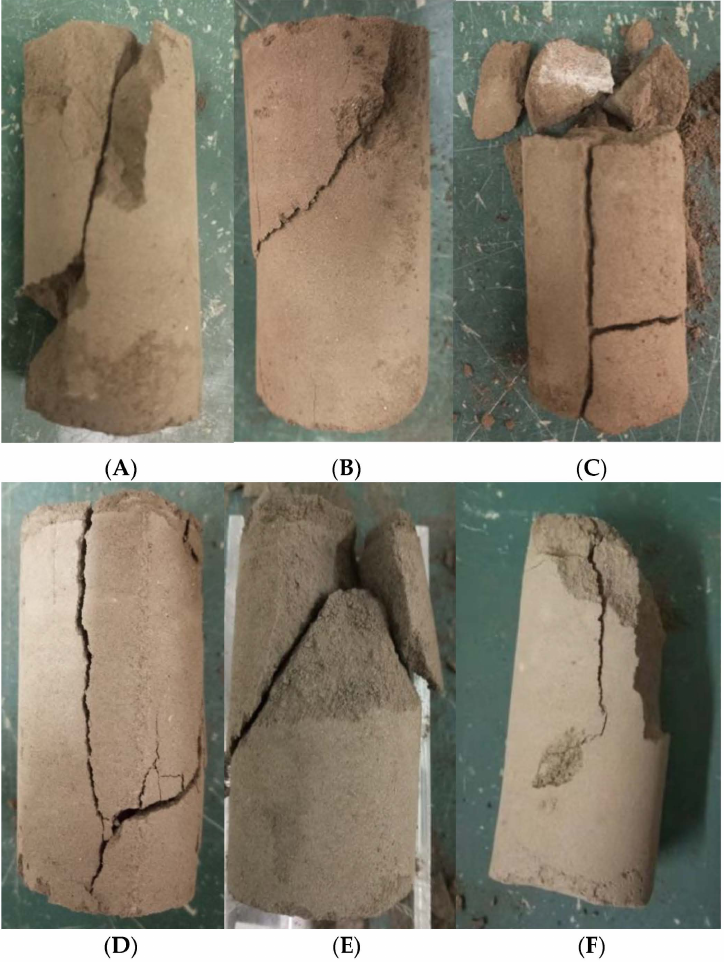
Molecules 2022 , 27 , x FOR PEER REVIEW Figure 3. ( A – F ) The failure diagrams of samples with 1–6 rounds of grouting.